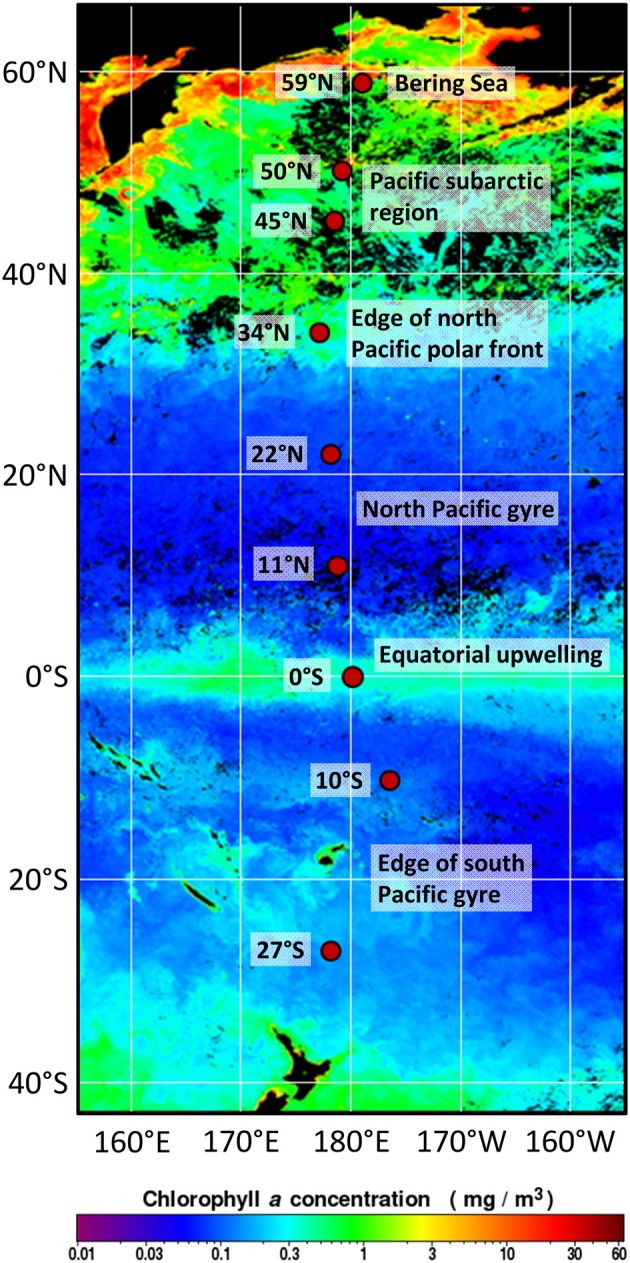
Positions of the investigated sampling sites in the Pacific along the 180° meridian from 27°S to 59°N. Sediment samples were taken at various water depths during RV Sonne expedition SO248, crossing the main oceanic provinces as classified by Longhurst (2007). The satellite map of chlorophyll a concentrations at the sea surface during May 2016 was modified from OceanColorWeb (Gene Carl Feldman; https://oceancolor.gsfc.nasa.gov/cgi/l3).